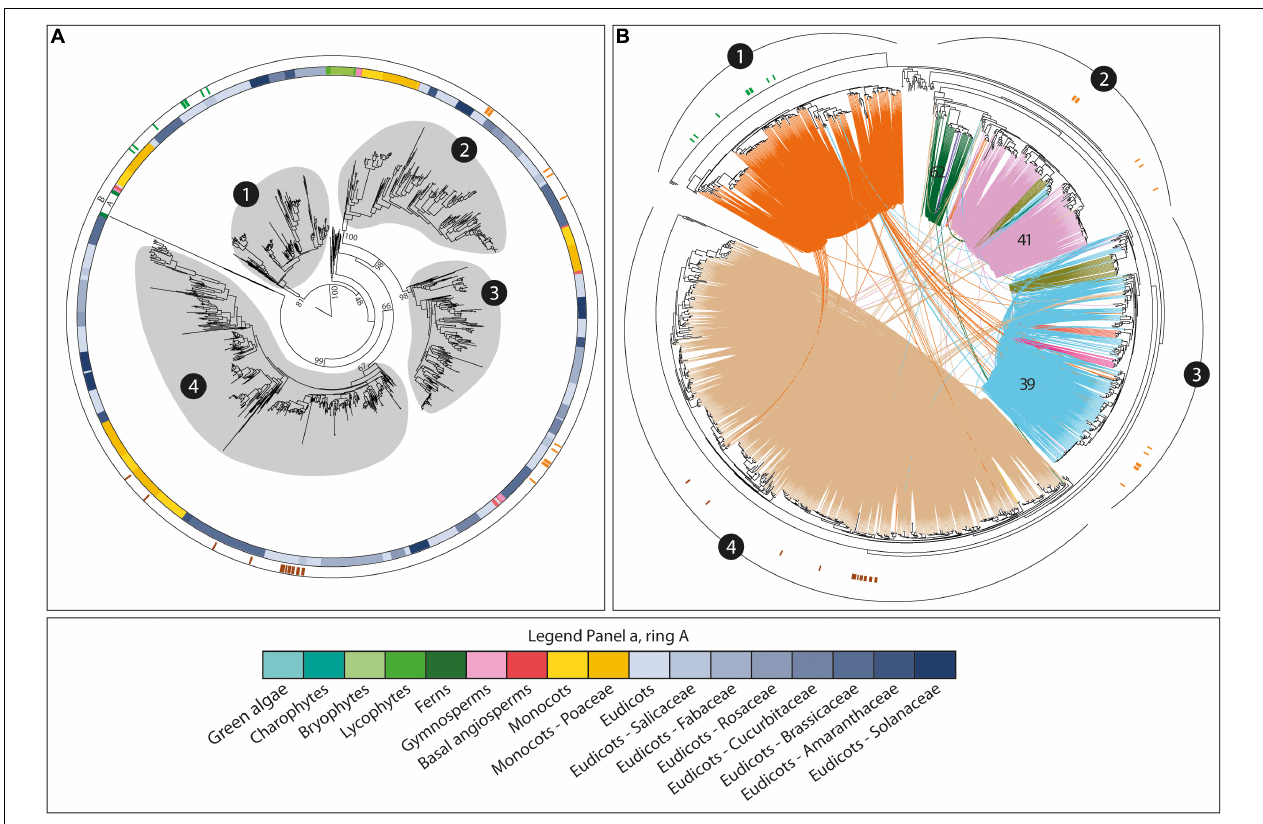
FIGURE 4 | The phylogenomic structure of the CslD family. The trees highlight the association between the phylogenetic and the conserved (syntenic) architectural structure of the family, and also the functional diversity of the CslD genes. (A) The phylogenetic tree of all the CslD genes from the 193 genomes with a BUSCO representation ≥ 75% and at least five genes per scaffold on average. Ring A represents the species taxonomy of the different genes (legend at the bottom of the figure). Ring B represents the tree position of several CslD genes known to be involved in the determination of vegetative organ size (green), pollen development (orange), or root hair formation (brown). Circles around tree branches highlight the four major CslD clades detected in the tree. Bootstrap values supporting clades subdivisions are reported. (B) Syntenic structure of the four CslD phylogenetic clades. Lines connecting tree leaves indicate syntenic connections between genes, with different colours highlighting different syntenic communities. Numbers in black circles refer to the four clades of panel A, while numbers on syntenic connections indicate community numbers as referred in the article.